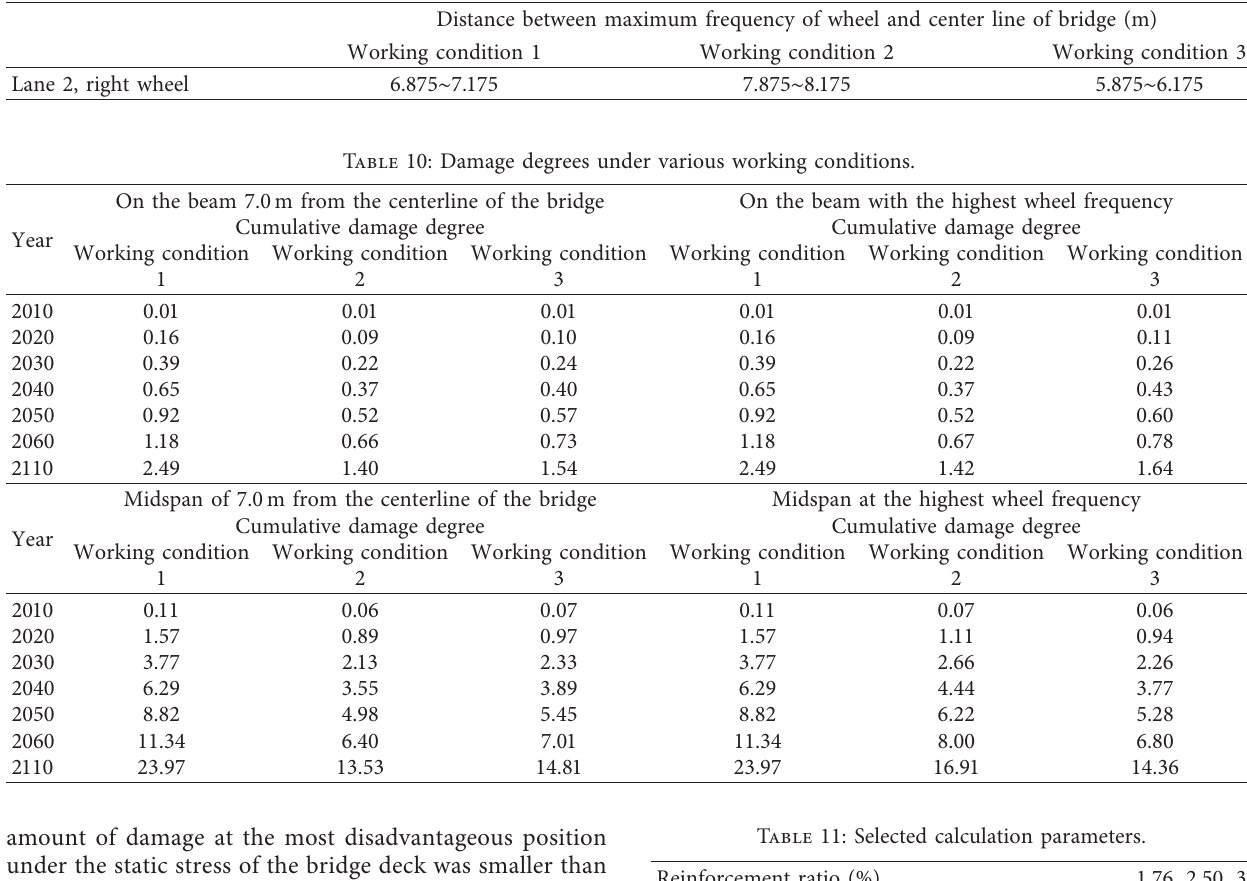
Table 9: Distance between the maximum frequency position of wheel and the centerline of the bridge under various working conditions.